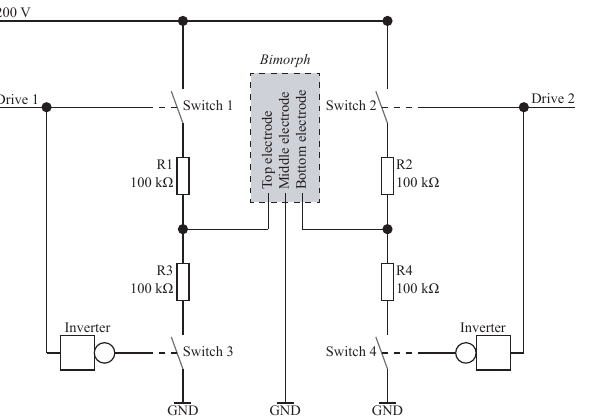
Figure 4. Circuit diagram powering 1 set of 10 piezoelectric bimorphs connected in parallel.